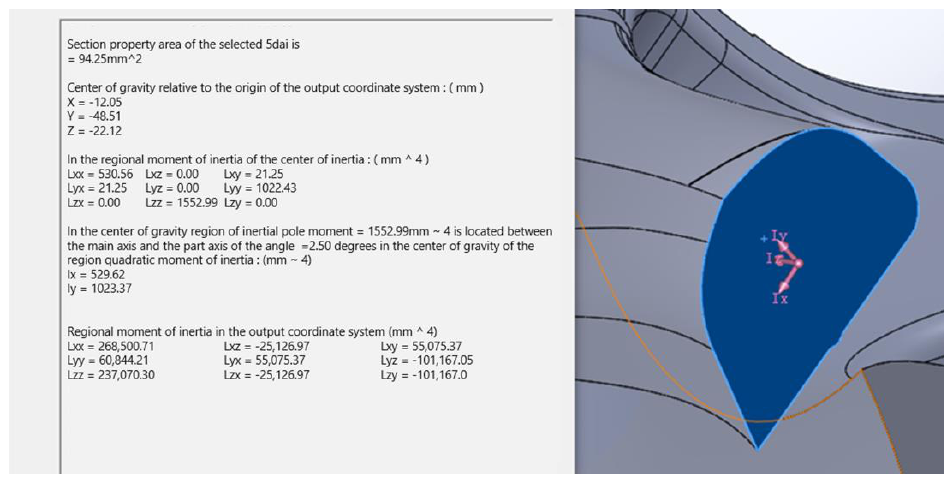
Figure 7. Resolution of the 0.51 radius theoretical stress concentration factor. Table 1. Calculation formula of correlation theory stress concentration factor 𝐾 𝑡 (PP).